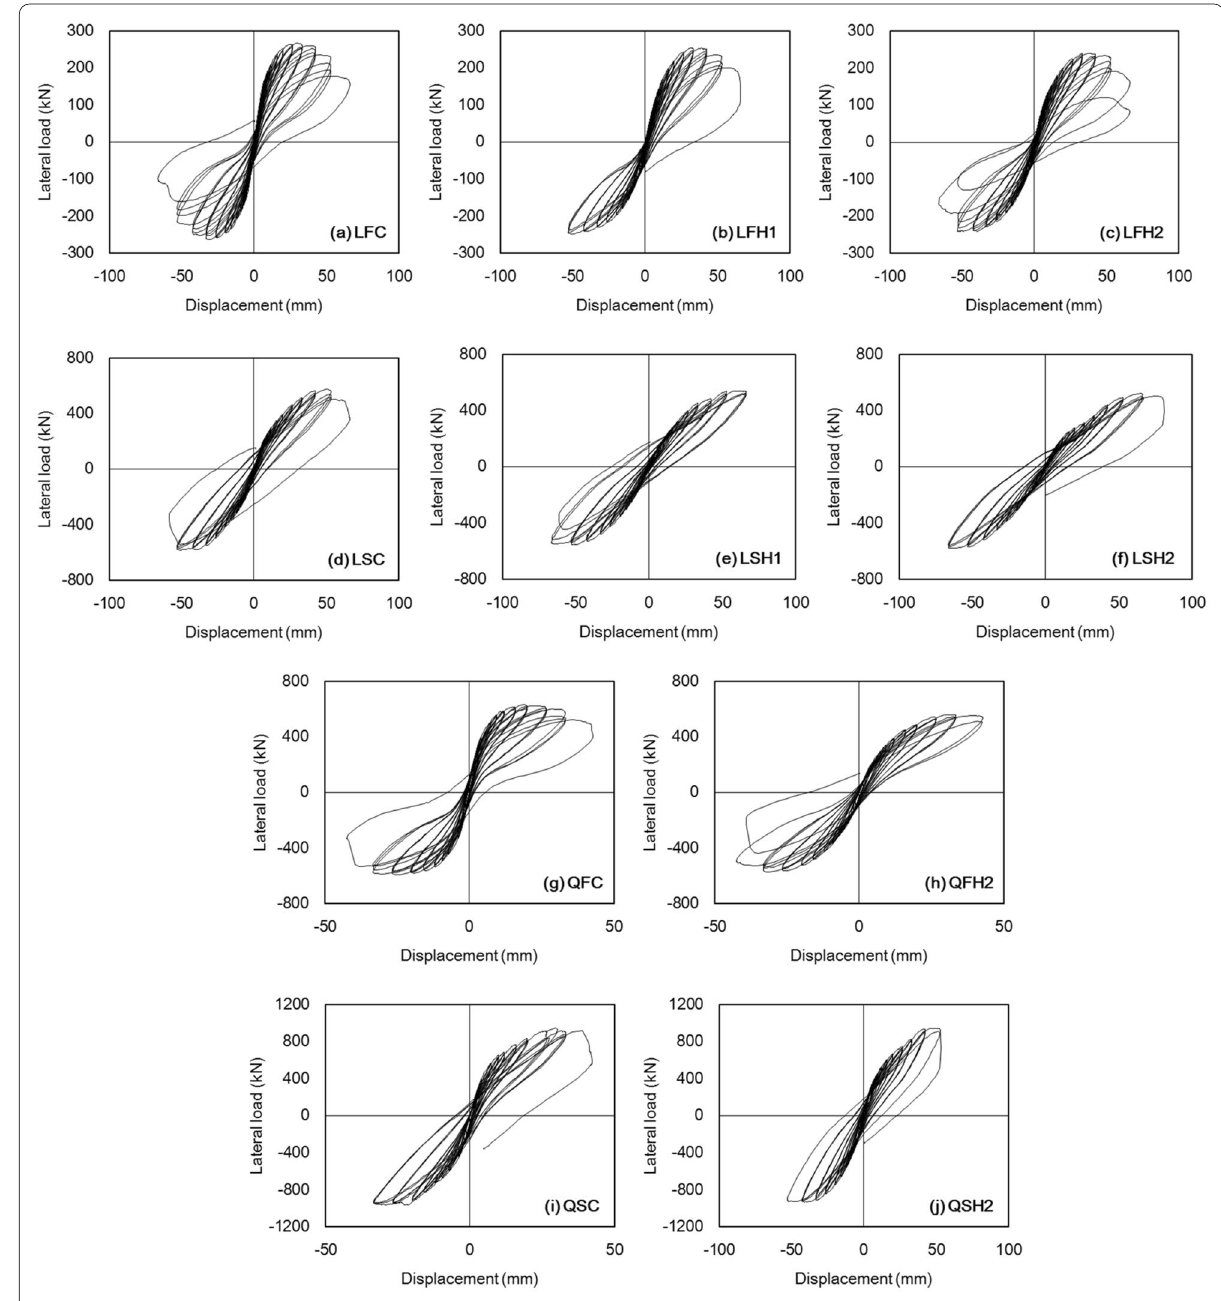
Fig. 12 Hysteresis curves of the